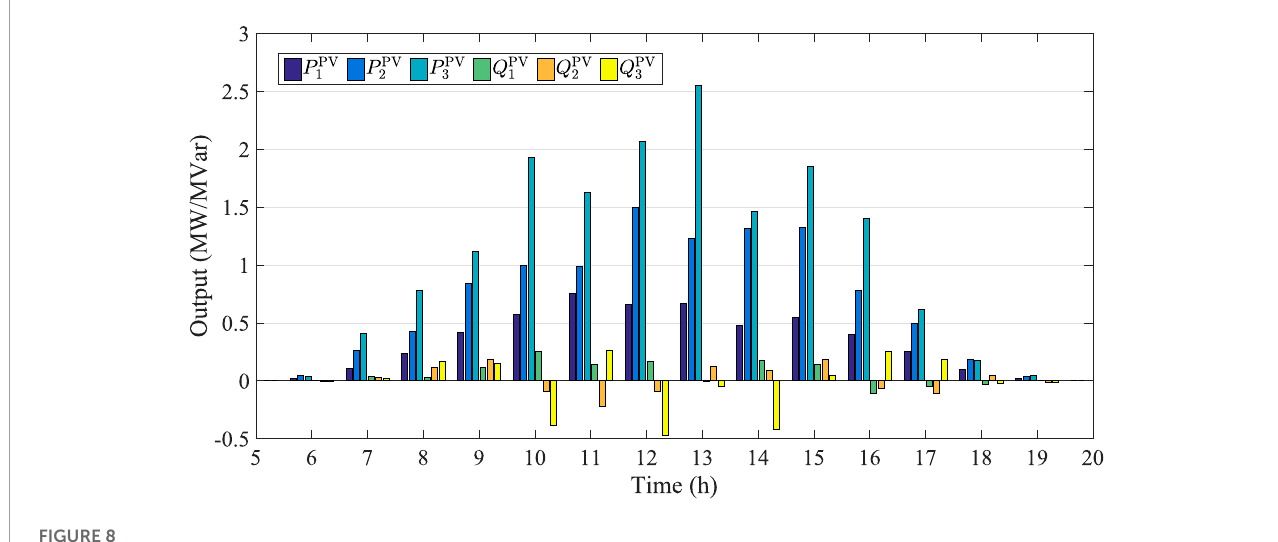
FIGURE 8 The optimal active and reactive power of PV inverter.